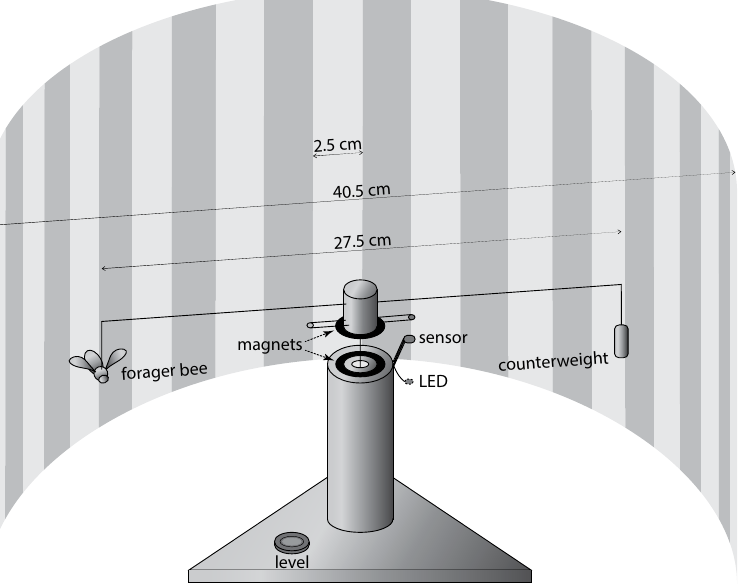
Figure 2. The flight mill used to test the flight ability of tethered forager bees. Foragers were attached to the wire flight mill arm through their tube harness, previously placed on top of their thorax. Once on the flight mill, bees could fly and their flight parameters were recorded by the sensor. The red LED is only triggered to light by the small triggering magnet opposite the bee, and therefore this weak red flash is not visible to the tested